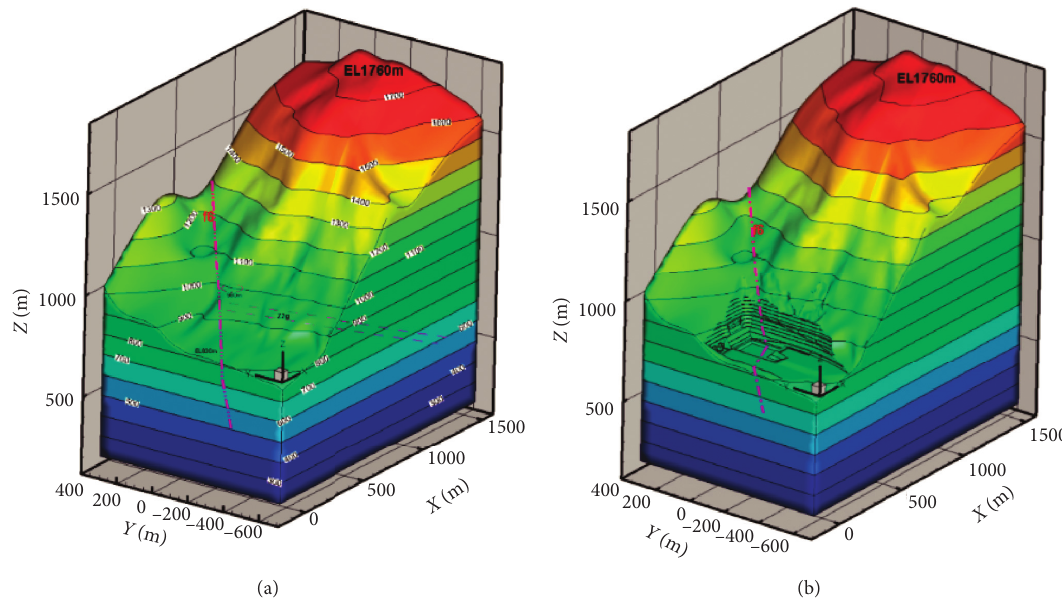
Figure 3: (a) Slope generalization model before excavation. (b) Slope generalization model after excavation.